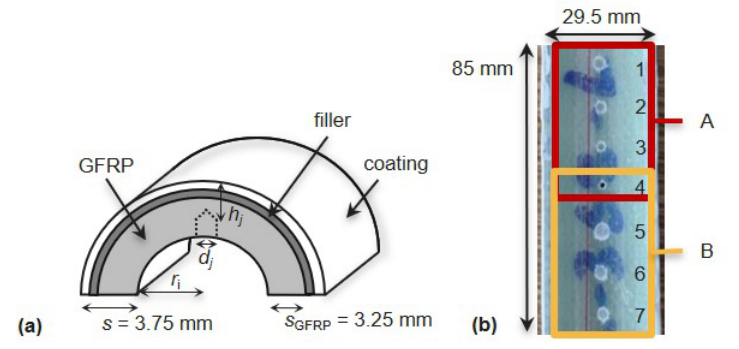
Figure 2. ( a ) schematic representation of the test specimen structure, ( b ) photograph of the rear side of the test specimen with seven drillings to imitate voids in the